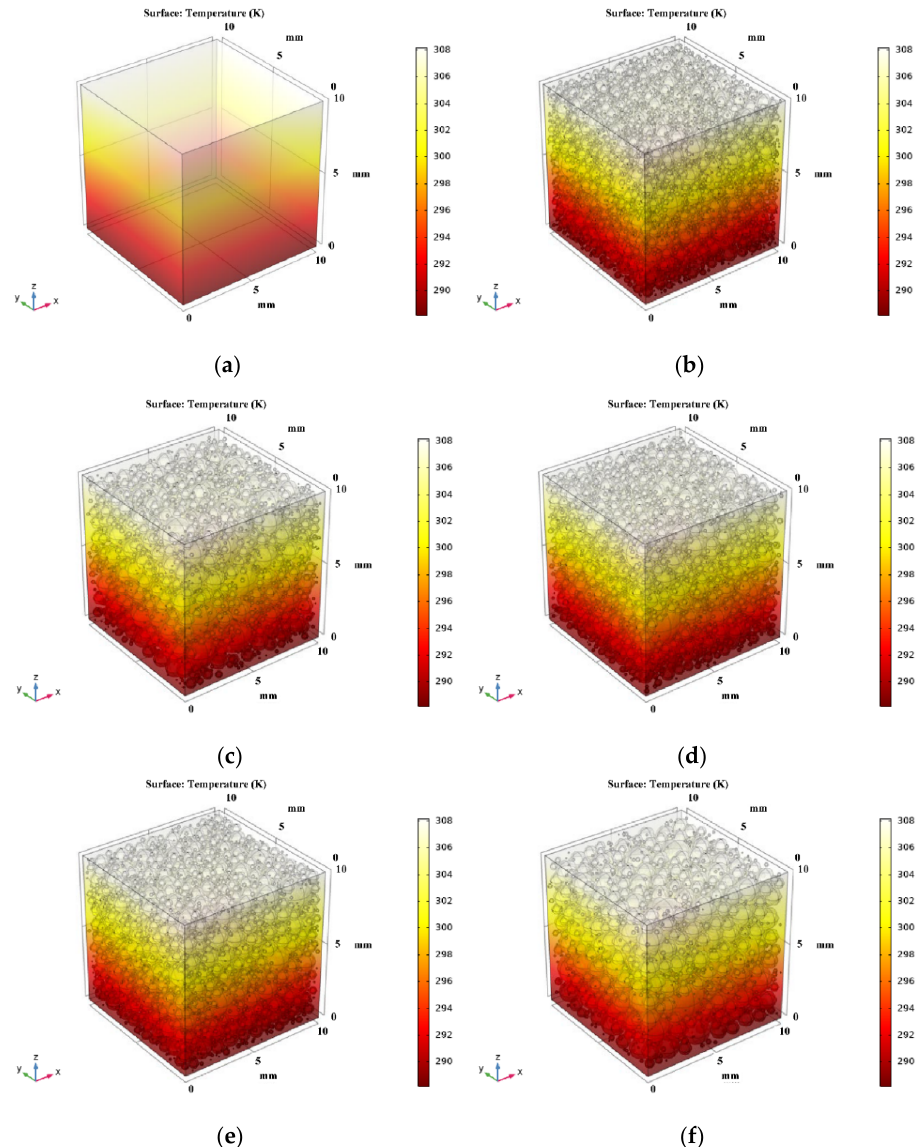
Figure 10. ( a ) Temperature distribution of reference concrete; temperature distribution of NAAC specimens at ( b ) 30 °C, ( c ) 35°C, ( d ) 40 °C, ( e ) 45 °C and ( f ) 50 °C.